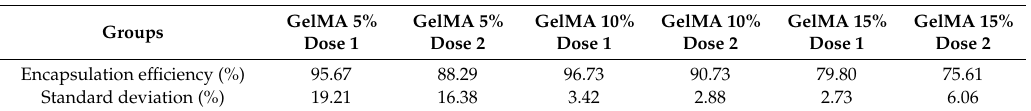
Fluorescein-5-isothiocyanate (FITC)-Abraxane ® encapsulation e ffi ciency in gelatin methacryloyl (GelMA). Results are normalized to control (same amount of free drugs in solution), shown as means and standard deviations, n =